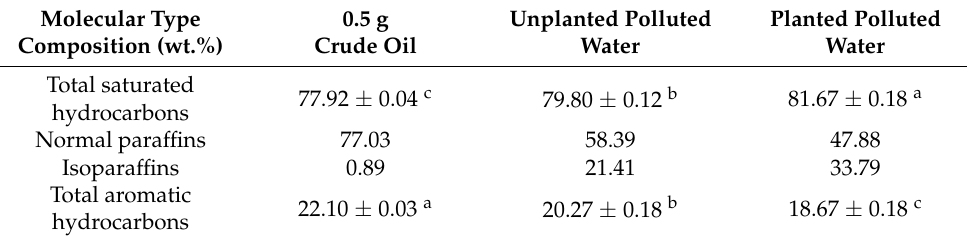
Table 1. The molecular type composition of different petroleum hydrocarbon fractions (wt.%) extracted from oil-polluted freshwater after a 7-daygrowth period of the A-A combination following exposure to 0.5 g/L crude oil pollution. The results are compared with their initial and residual weight percentages in crude oil and the polluted unplanted control, respectively. Values are the mean ± SE, n = 3. The different lowercase letters from (a) to (c) indicate significant differences between crude oil and oil-polluted water without and with the A-A combination at p ≤ 0.05 according to Duncan’s multiple range